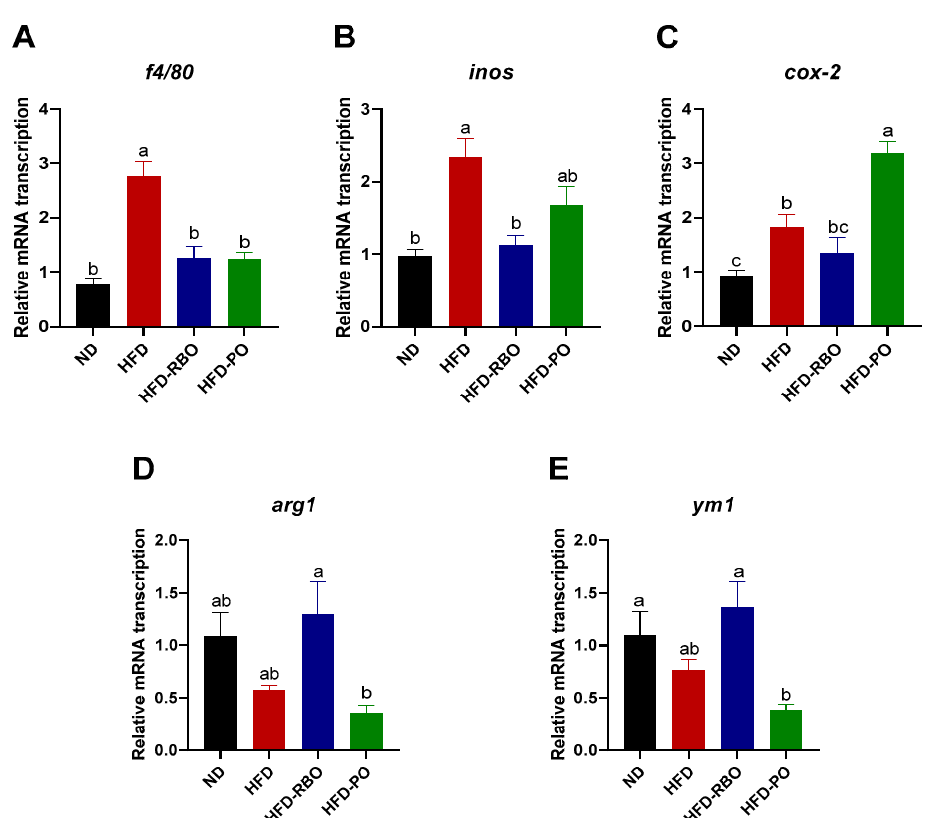
Figure 3. Analyses of mRNA transcription of macrophage polarization in eWAT by qRT-PCR. The mRNA transcription of macrophage marker ( A ) f4/80 , the M1 markers ( B ) inos and ( C ) cox-2 , and the M2 markers ( D ) arg1 and ( E ) ym1 in eWAT. Results were normalized to internal control β -actin gene by using the delta–delta Ct method (2 − ∆∆ Ct ). Data are presented as the mean ± SEM, and significant differences are indicated with different letters ( p < 0.05). (ND, normal diet; HFD, high fat diet; HFD-RBO, high-fat diet-rice bran oil; HFD-PO, high-fat diet-palm oil).